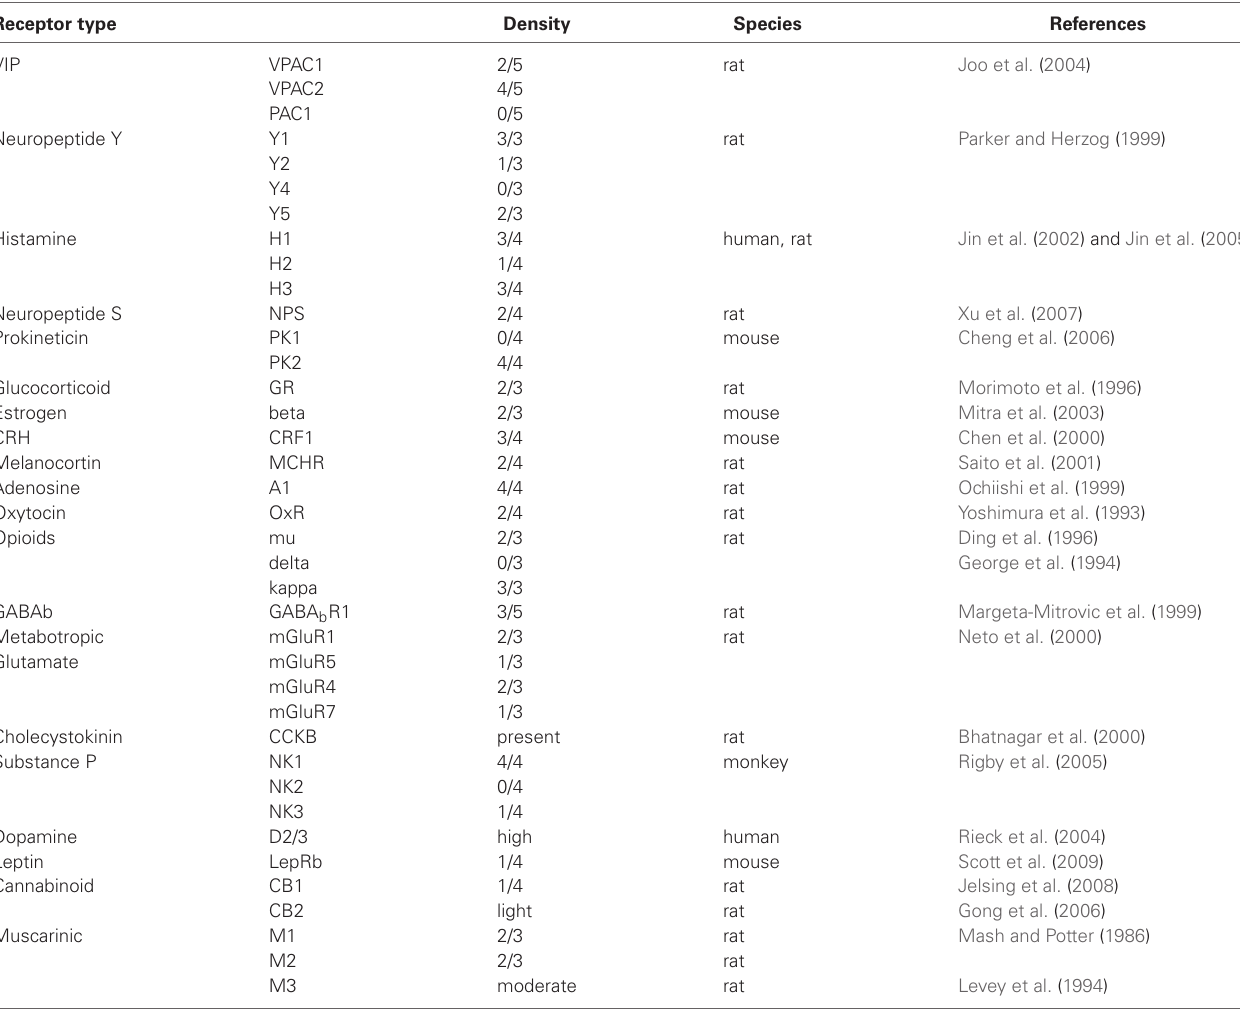
Table 2 | Summary table of additional neurotransmitter G-protein coupled receptors expressed in PVT